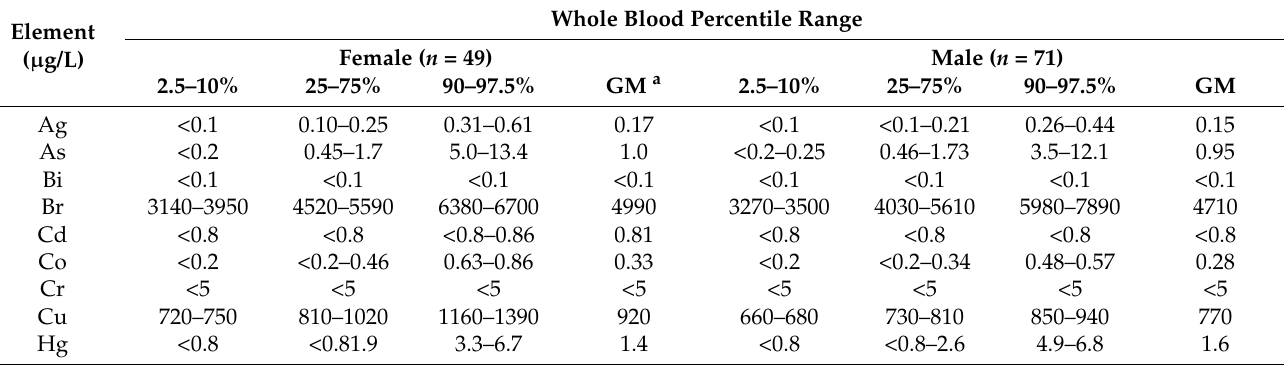
Table 8. Trace element levels in whole blood and plasma as percentile range for females and